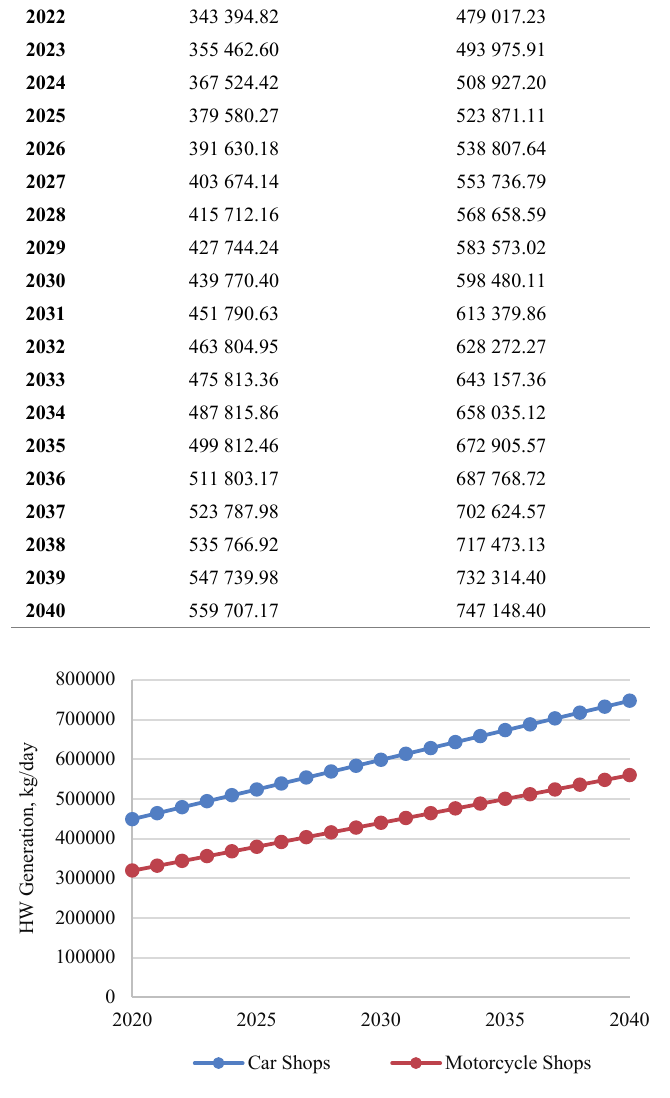
Fig. 4. Hazardous automotive shops waste generation projection in Bandung